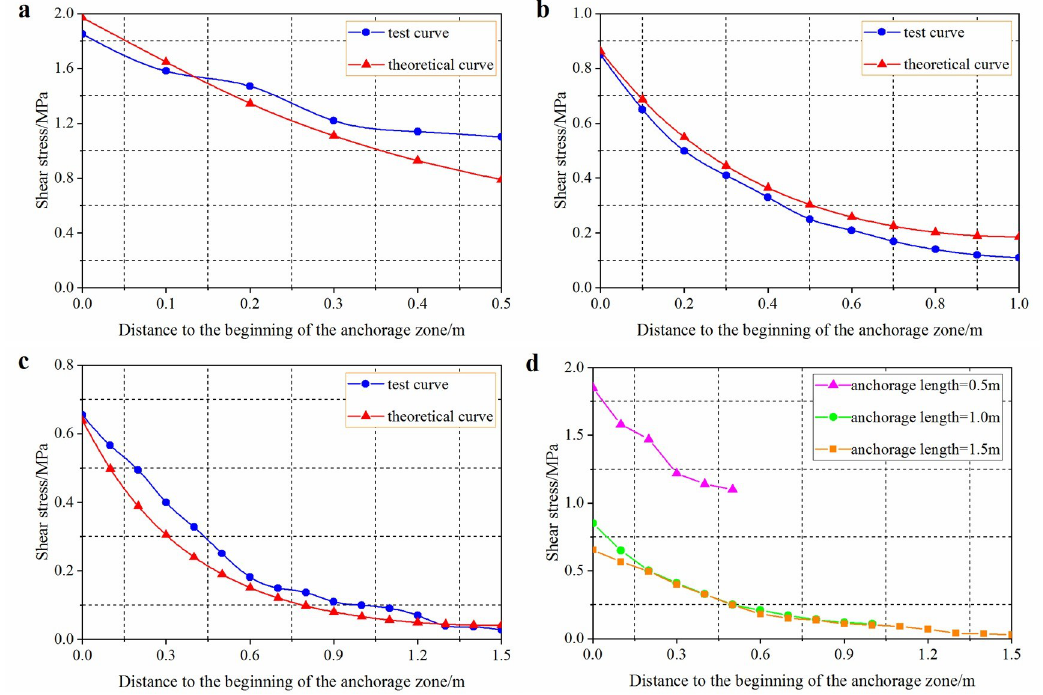
Fig 8. Shear stress distribution of anchorage body under a same pull-out force and different anchorage lengths. Anchorage lengths of 0.5 m (a), 1.0 m (b), and 1.5 m (c), (d) is the comparison of shear stress distribution of anchorage body when anchorage length is 0.5m, 1.0m and